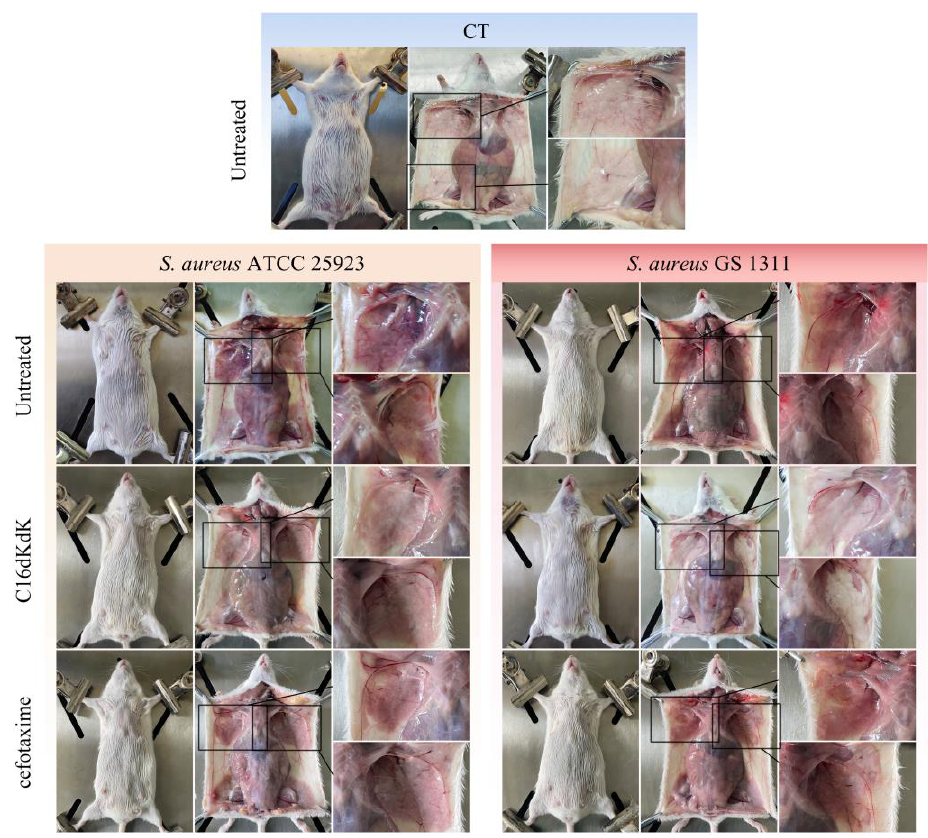
Figure 4. Mammary gland pathology in mice. “CT” indicates healthy mice, “ATCC25923” indicates S. aureus ATCC25923-infected group, and “GS1311” indicates S. aureus GS1311-infected group. “Untreated” indicates that this group of experimental animals did not undergo any treatment; “C16dKdK” indicates that this group of experimental animals received C16dKdK treatment; “cefotaxime” indicates that this group of experimental animals received cefotaxime treatment. The first column of each treatment group shows the mammary appearance of mice, and the second and third columns show the appearance of mammary tissue after the mice were dissected (where the third column shows a magnified image of the corresponding part of the second column, indicated by the corresponding arrow).